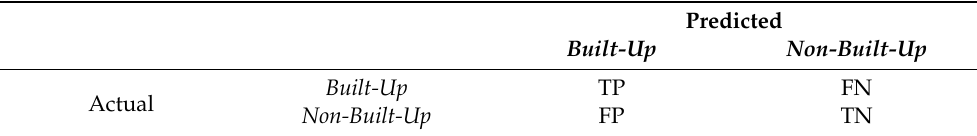
Table 1. Confusion matrix (TP: True Positive, TN: True Negative, FP: False Positive, and FN: False Negative).